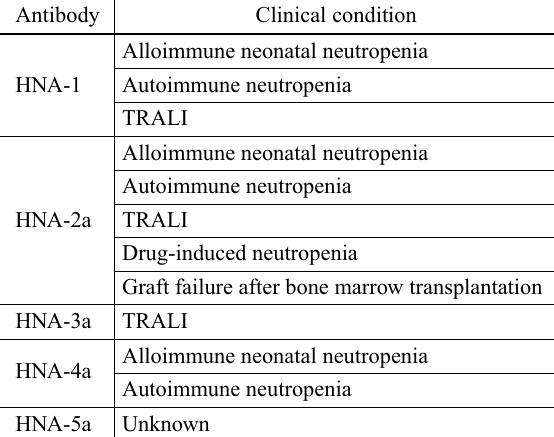
Clinical disorders caused by neutrophil specific